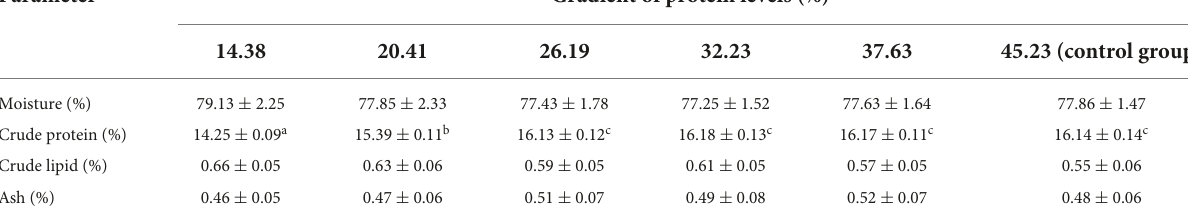
TABLE 1 Impact of a gradient of dietary protein levels on the muscle composition of softshell turtles, Pelodiscus sinensis (means ± SD, n = 15). Parameter